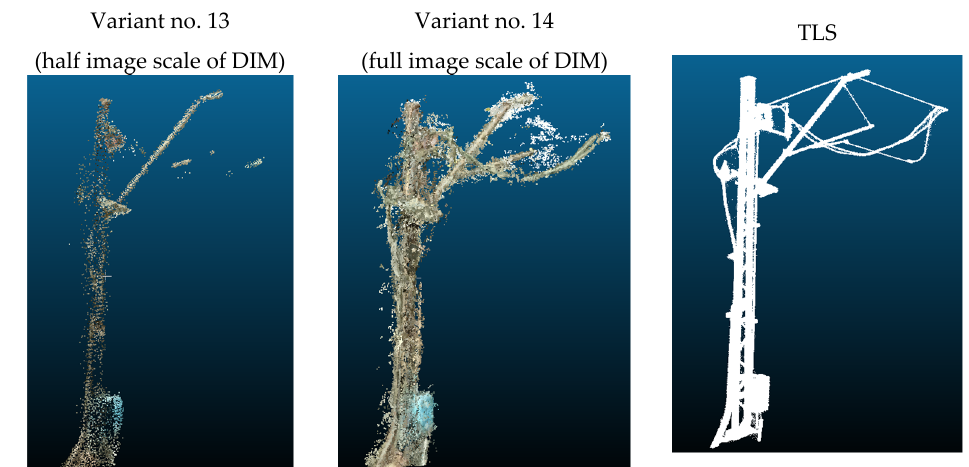
Figure 2 . Point cloud fragments clipped to the traction pole object for all analyzed variants. Figure 2. Point cloud fragments clipped to the traction pole object for all analyzed